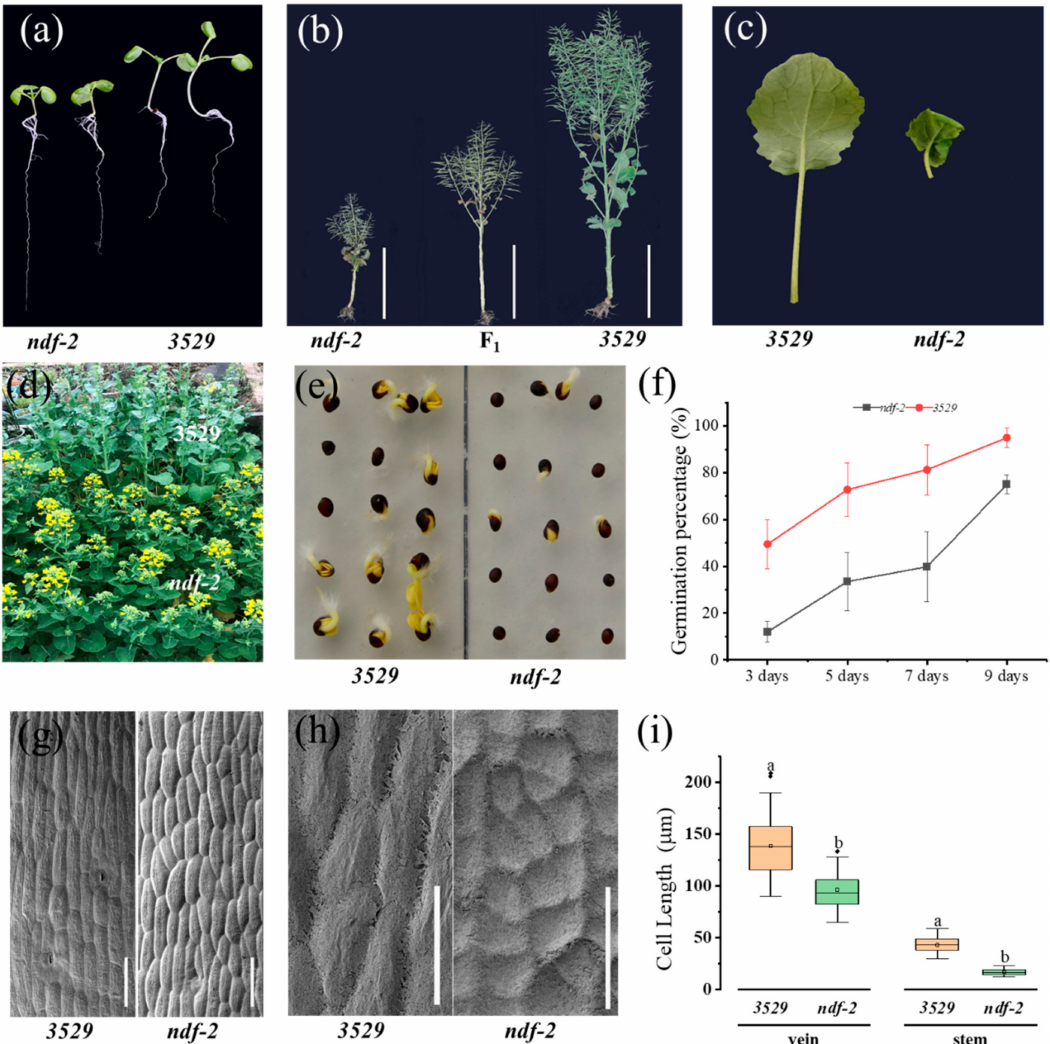
Figure 1. Phenotype of the ndf-2 mutant of rapeseed. ( a ) Comparison of 1-week-old 3529 (wild-type) and ndf-2 seedlings. ( b ) Morphology of the 3529 and ndf-2 at maturation stage. ( c ) Leaf morphology of 5-week-old 3529 and ndf-2 . ( d ) Difference in flowering time between 3529 and ndf-2 . ( e ) Seed germination of 3529 and ndf-2 . ( f ) Comparison of germination rate at 3, 5, 7 and 9 days between 3529 and ndf-2. ( g – i ) Scanning electron microscopy images of epidermal cells in veins ( g ) and internodes ( h ) of 3529 and ndf-2 , and quantitative comparison of cell lengths was made in ( i ). Statistically significant differences were revealed using Student’s t-test: p < 0.05, different lowercase letters denote significant differences between wild-type and